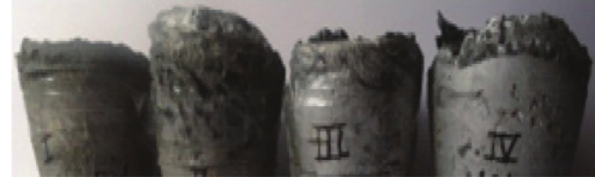
O /SiC hybrid 2 3